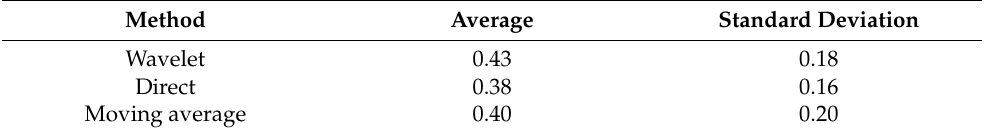
Table 7. SOC parameters: AR = 90%.